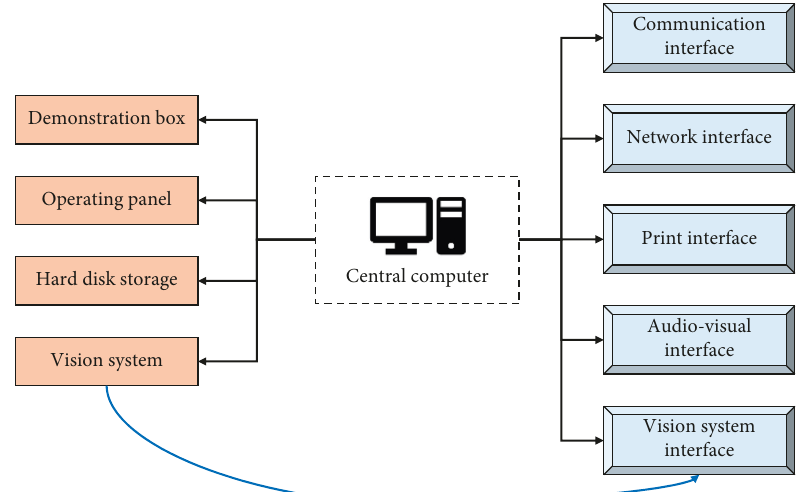
Figure 1: Component of robot control system.